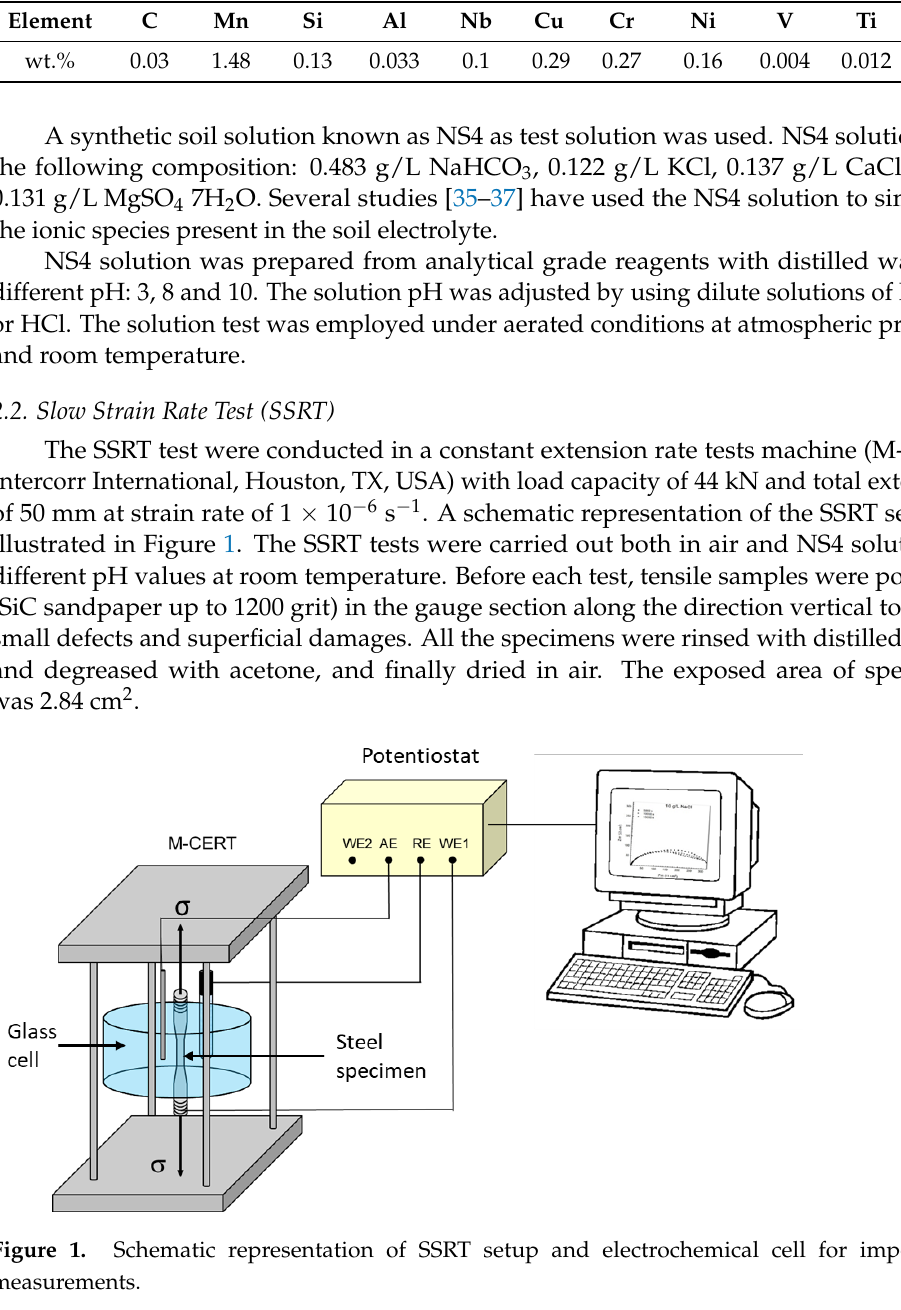
Table 1. Chemical composition of API X70 steel (wt.%).